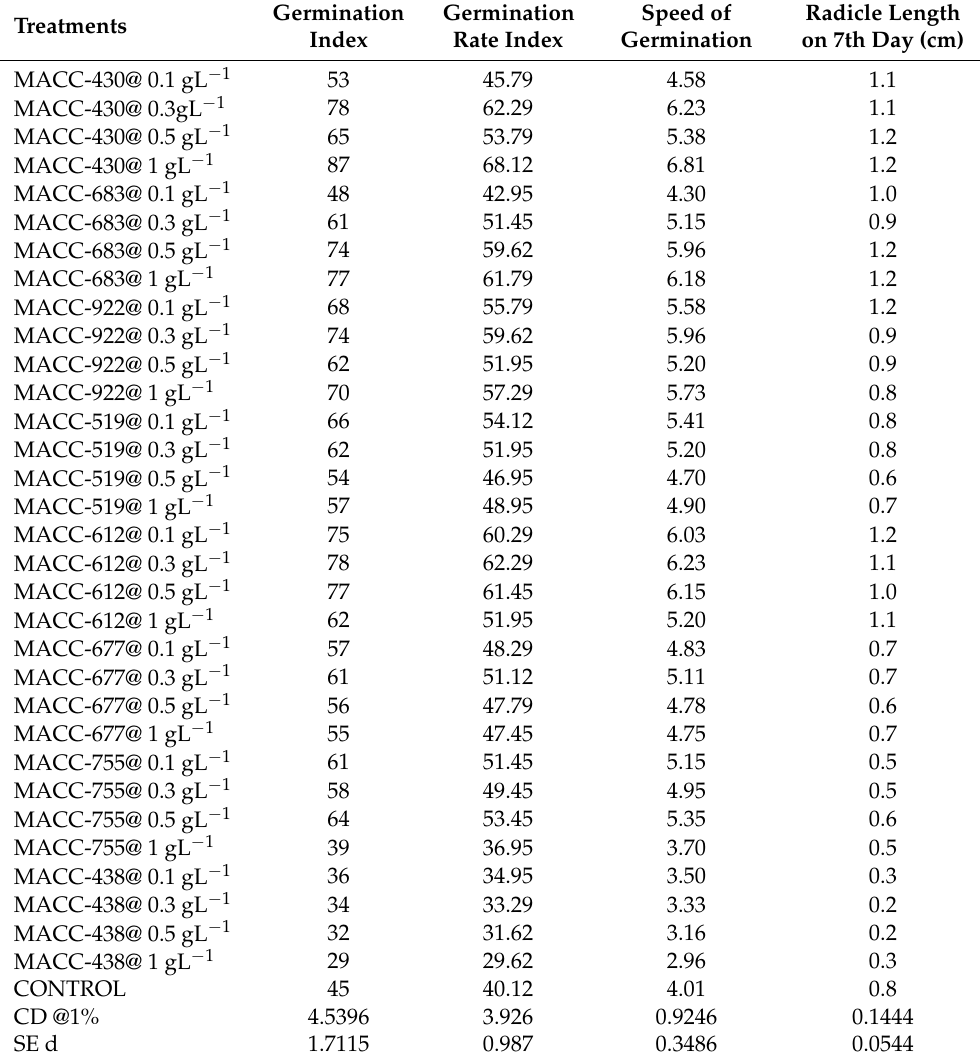
Table 1. Different germination parameters of Mv N á dor winter wheat under the influence of various concentrations and strains of microalgae. The critical difference (CD) with a p -value of 0.01 (1%) and standard error (SEd) was